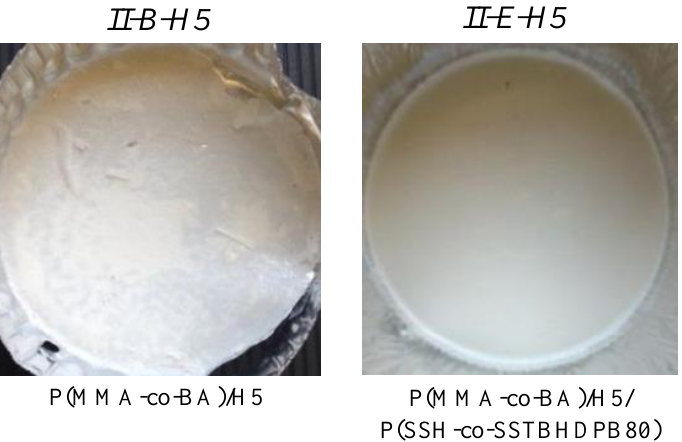
Figure 4. Photographs of the films P(MMA-co-BA)/H5 and P(MMA-co-BA)/H5/P(SSH-co- SSTBHDPB80).